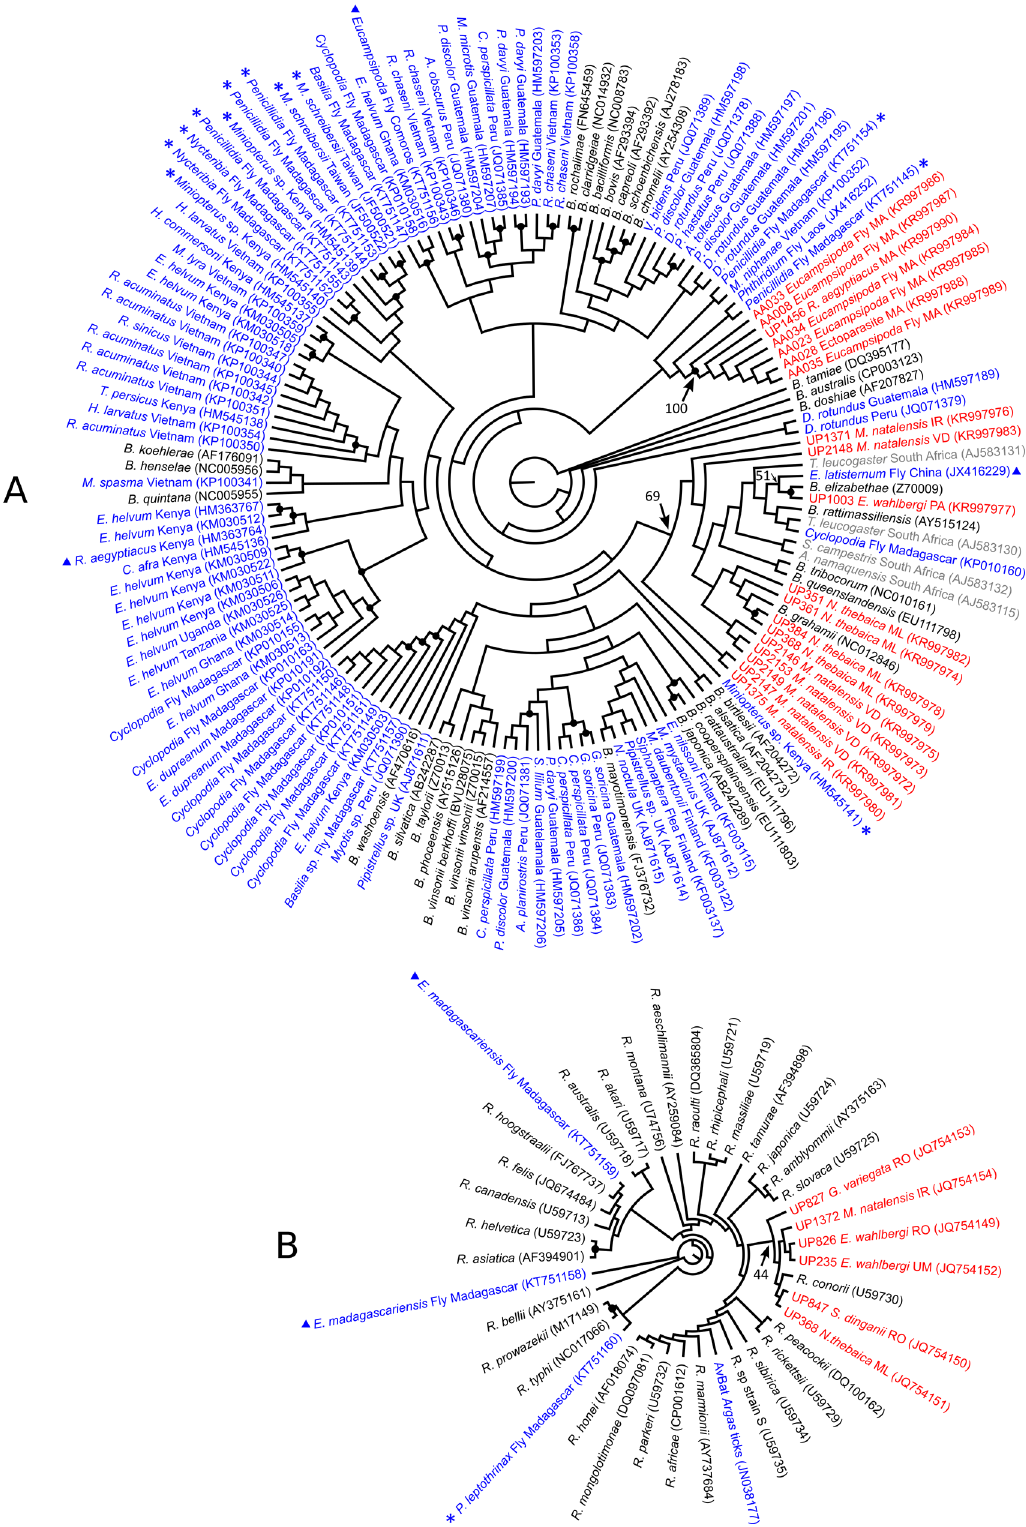
Fig 2. Phylogenetic relationships of Bartonella (A) and Rickettsia (B) spp. detected in bats and their ectoparasites from South Africa and Swaziland. Black dots indicate bootstrap > 0.75. Bootstrap values for nodes of interest are indicated by an arrow. Trees were built under the TIM3+G and